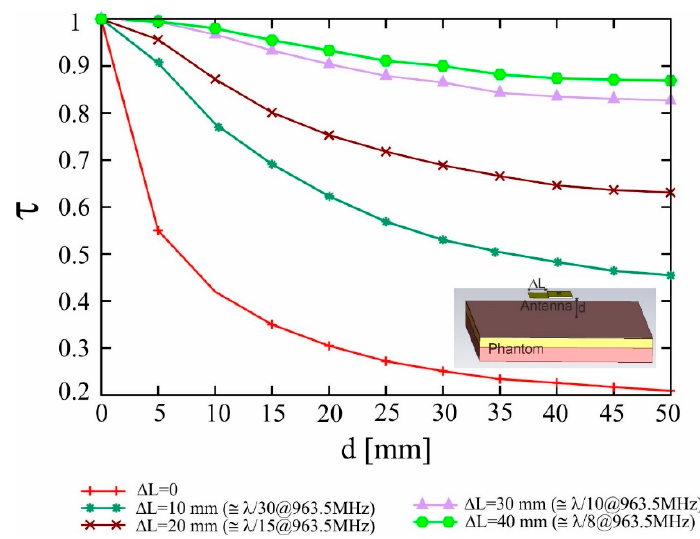
Figure 4. τ with respect to the distance from the body phantom for different extensions of the antenna ground plane.